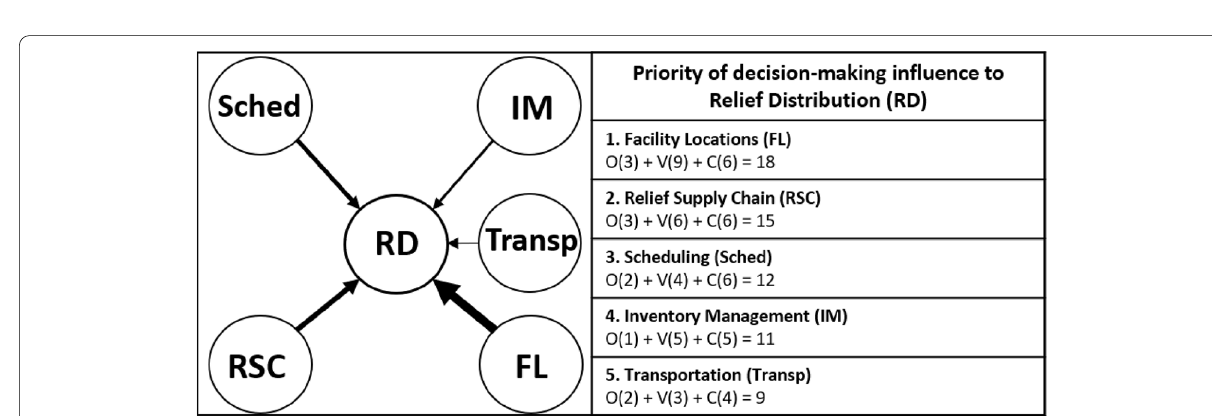
Fig. 5 The conceptual framework of relief distribution